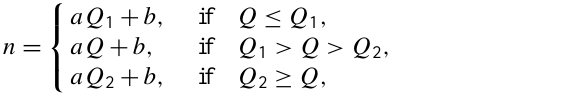
Fig. 5. Comparison of MSS and HEC-RAS unsteady flow inunda- tion area for ZOO.